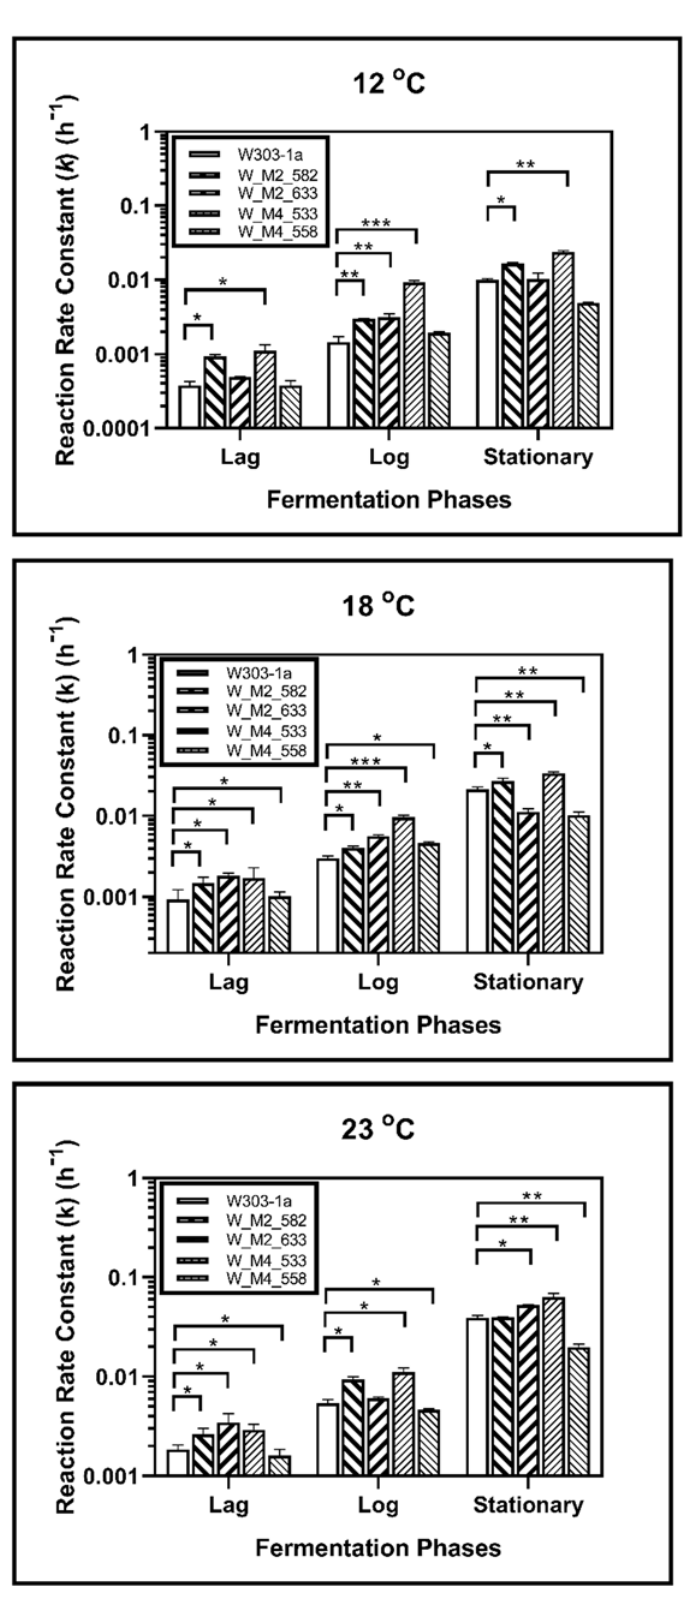
Figure 4. Reaction rate constants of alcohol formation during alcoholic fermentation regarding phases for each strain at 12, 18 and 23 °C. The statistically significant differences are nominated by asterisks: (* p < 0.05, ** p < 0.001, *** p < 0.0001).